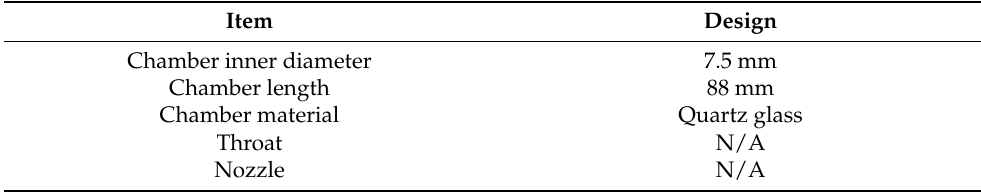
Table 3. Chamber